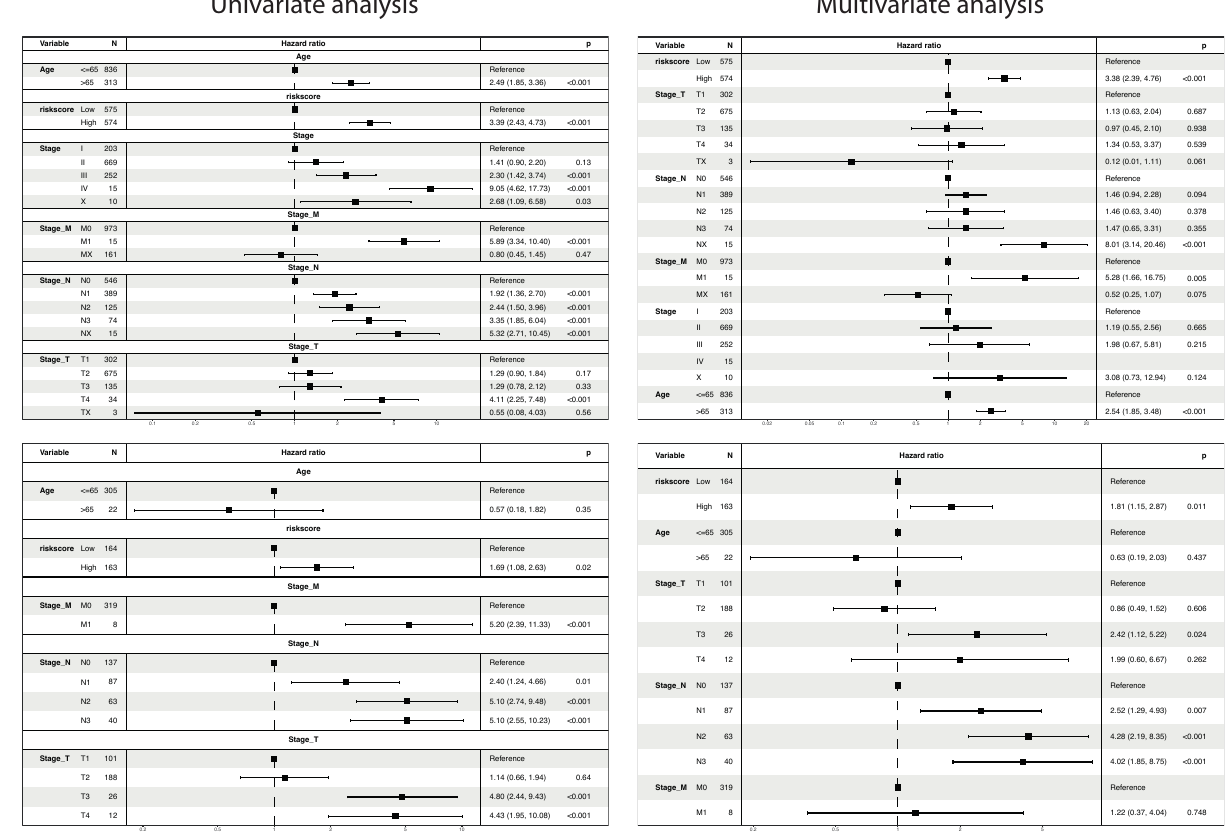
Figure 11. Signature is an independent prognostic factor of survival. For the clinical features that were significant in both univariate and multivariate Cox analyses in the above analysis, the clinical features were grouped in the TCGA dataset to explore the prognostic efficacy of the signature (Figure 12).